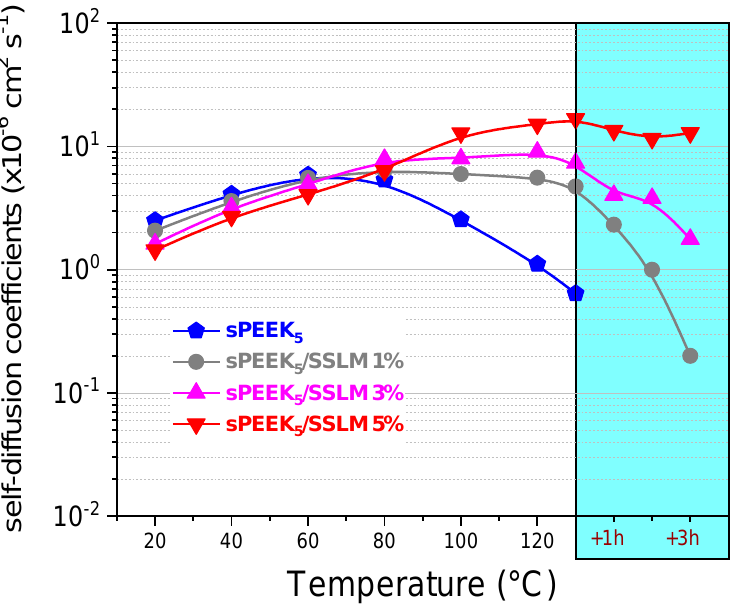
Figure 10. Water self-diffusion coefficients as a function of the temperature (from 20 °C up to 130 °C) for sPEEK 5 and composites membranes. Diffusivity data collected at 130 °C after several hours are also plotted.